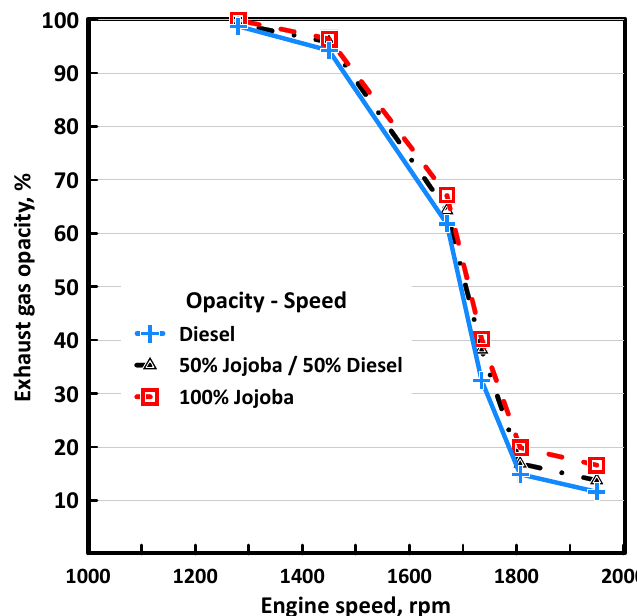
Figure 8. Exhaust gas opacity of pure diesel fuel, raw Jojoba oil, and 50/50 blend.